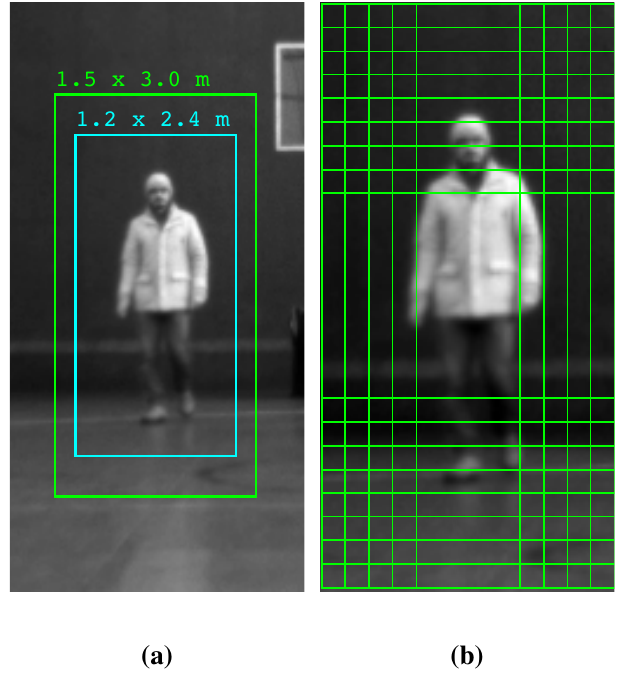
Figure 4. Fixed and adaptive projection methods. ( a ) Projection of the same cluster for different corresponding sizes. The cyan rectangle is used in the fixed case, and the larger green window is used in the proposed adaptive method. ( b ) In the adaptive method, the region of interest (ROI) is scanned by an overlapping sliding window over multiple